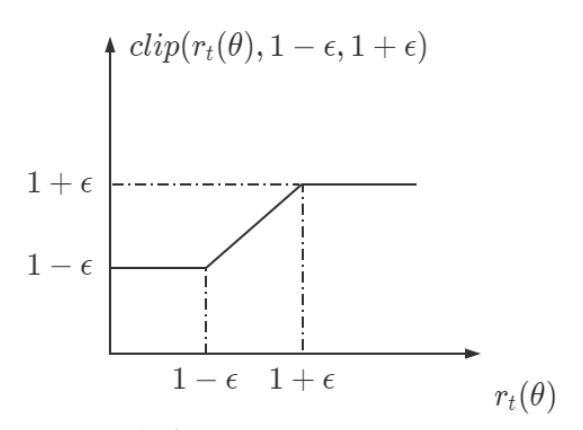
Figure 3. Clip function.